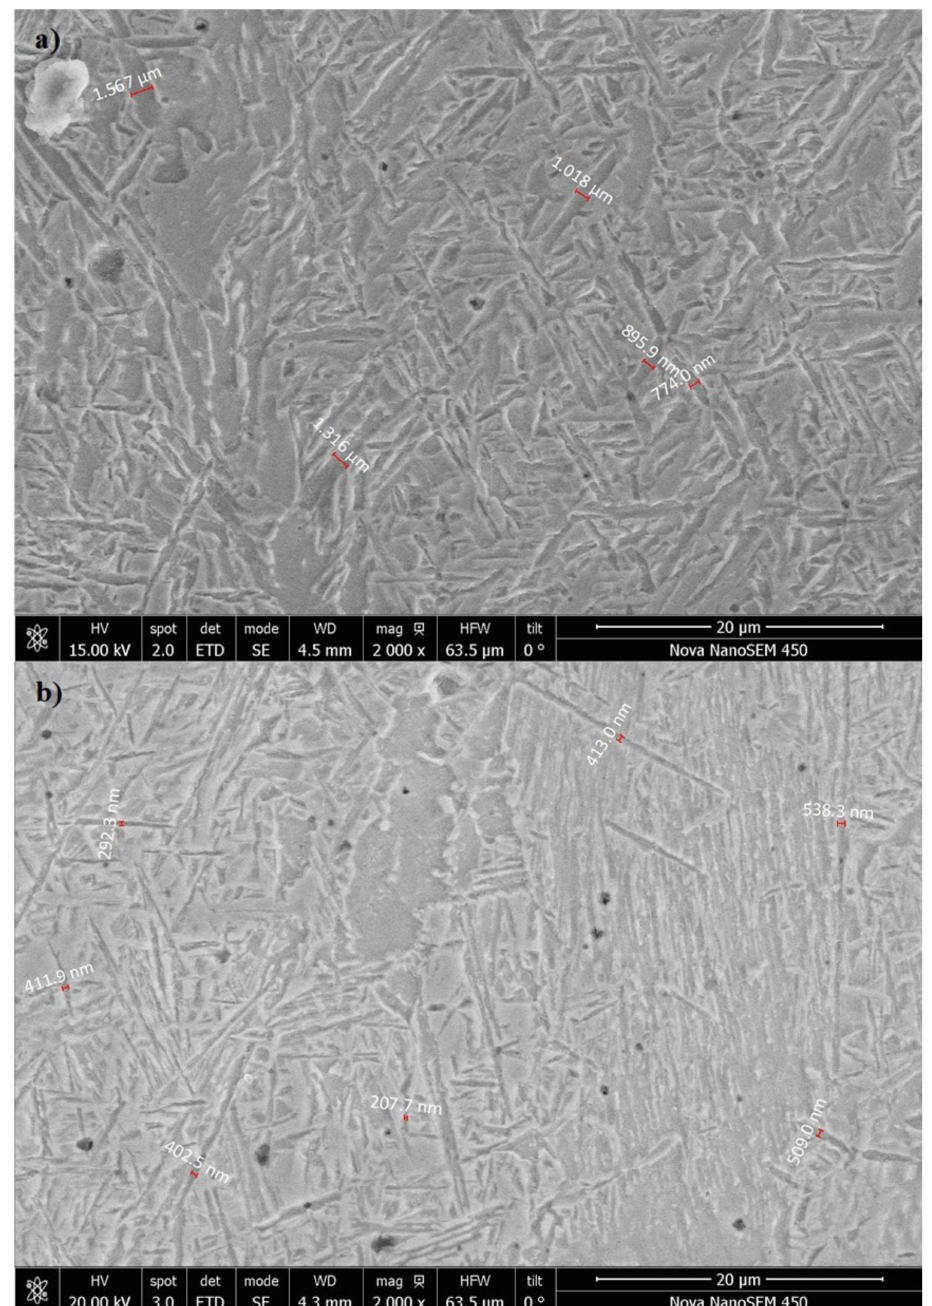
Figure 8. SEM images of both fusion zones with measurements of microstructure ledges thickness: ( a ) GMA FZ and ( b ) laser